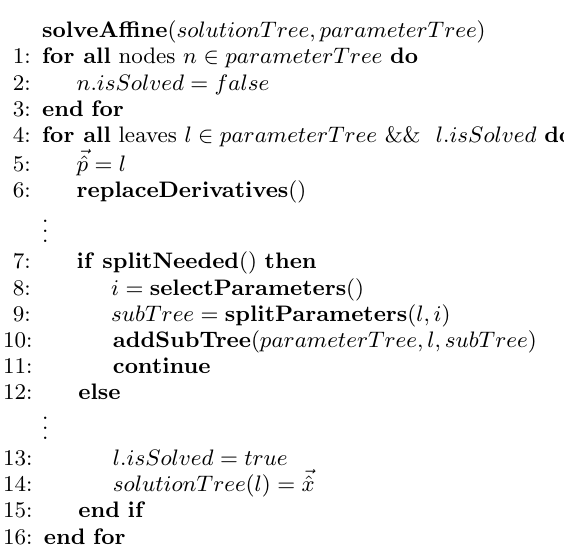
Figure 5: Selection of parameter to split, select- ByX with X ∈ { Deviation, Sensitivity, Sensitivity- AndDeviation, EPDAndPPD, EPDAndSensitivity }